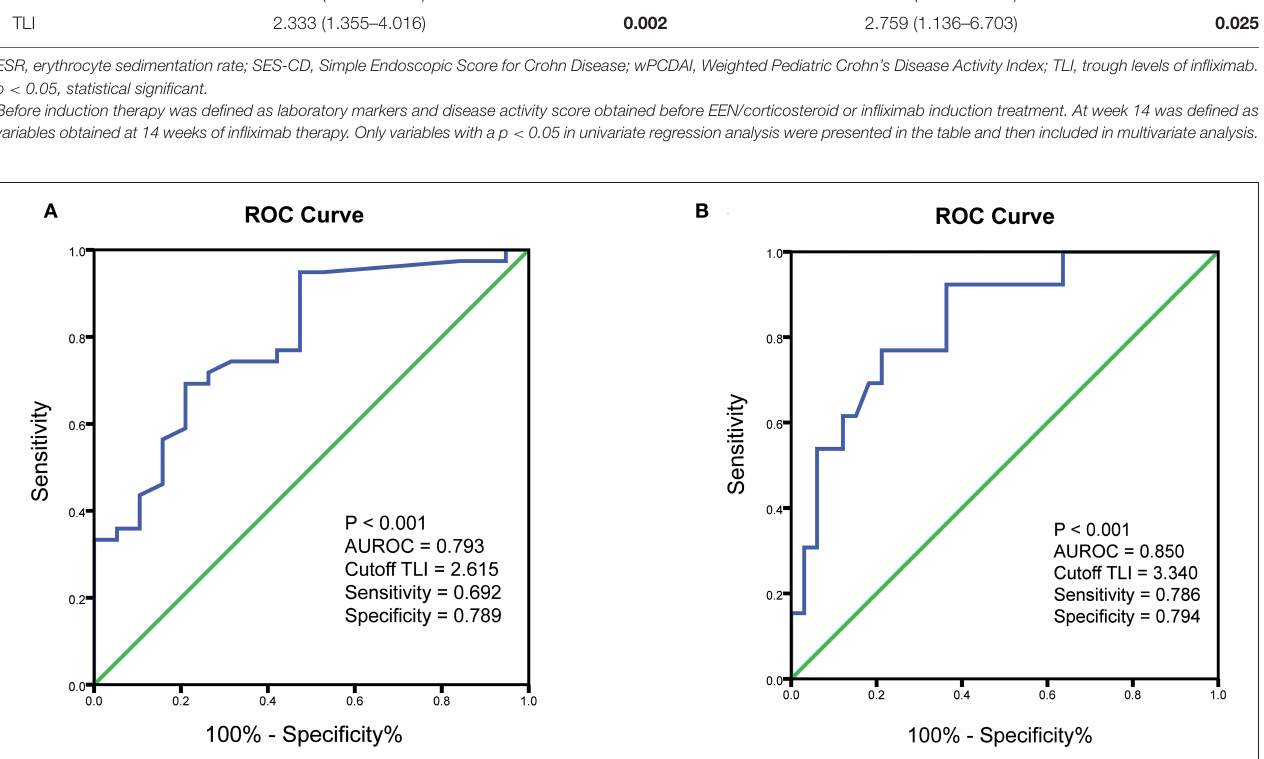
FIGURE 1 | ROC curves showing the association of TLI with clinical outcomes. (A) ROC curve to identify the threshold value of TLI associated with clinical remission. (B) ROC curve to identify the optimal cutoff for TLI associated with endoscopic remission. ROC, receiver operating characteristic; TLI, trough levels of infliximab; AUROC, area under the ROC